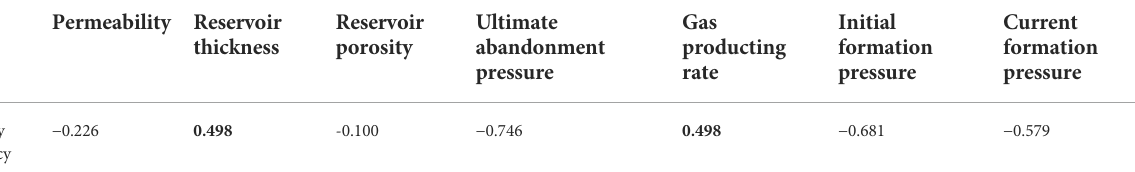
TABLE 3 Correlation matrix between gas recovery and in fl uencing factors.